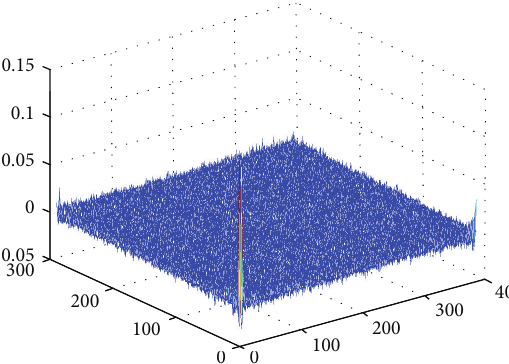
Figure 7: POC function for IIT Delhi palmprint database.